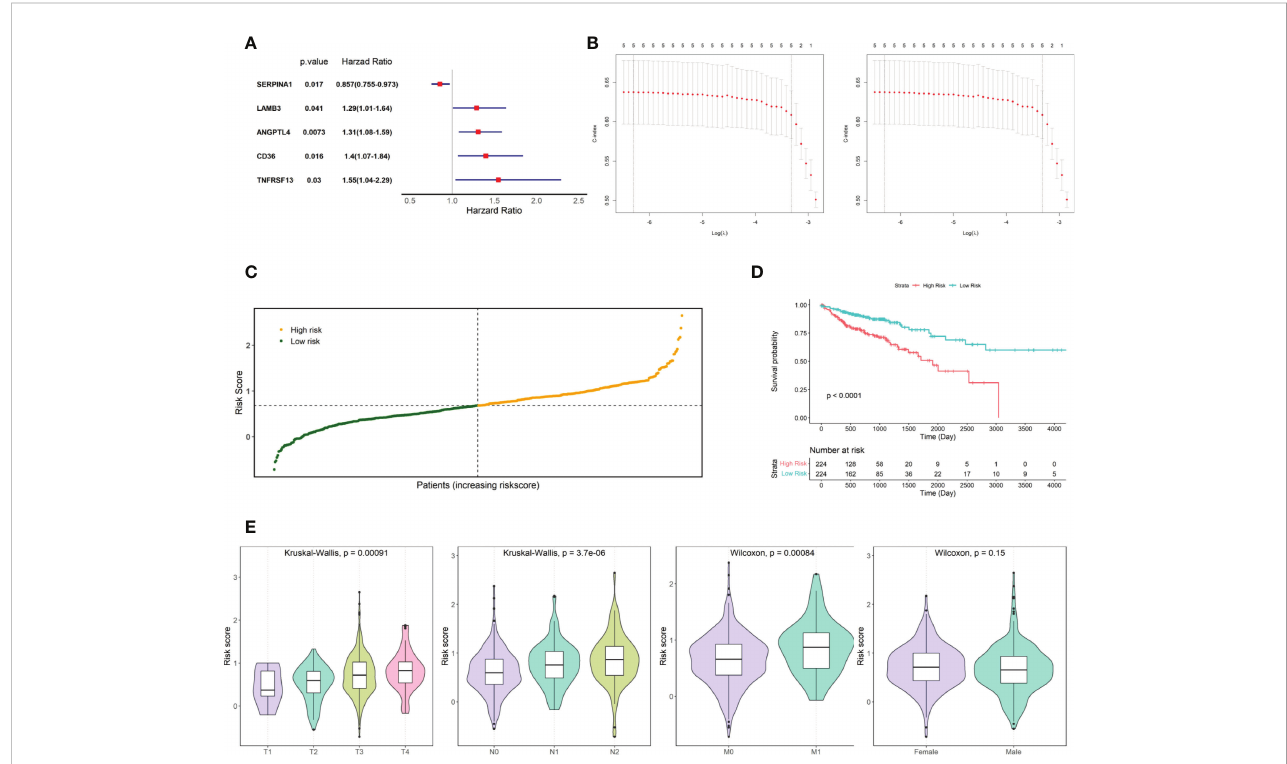
FIGURE 2 Screening for prognosis-associated genes. (A) Prognosis-associated gene Hazard Ratio display. (B) LASSO regression analysis. (C) TCGA COAD cohort risk score distribution. (D) KM curves for high- and low-risk groups in the TCGA COAD cohort. (E) Risk score distribution of patients at different TNM stages and different